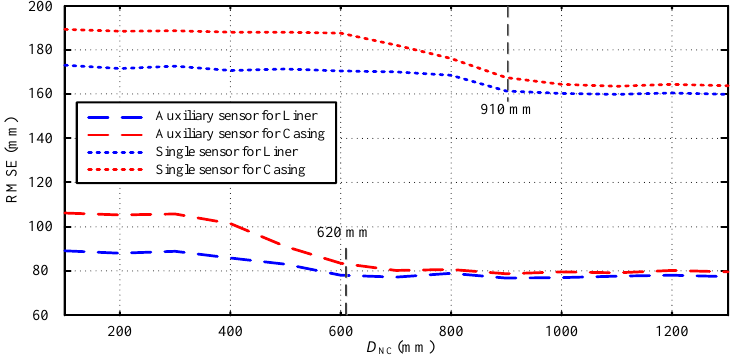
Figure 18. Root-mean-square error (RMSE) of each collar versus D NC .